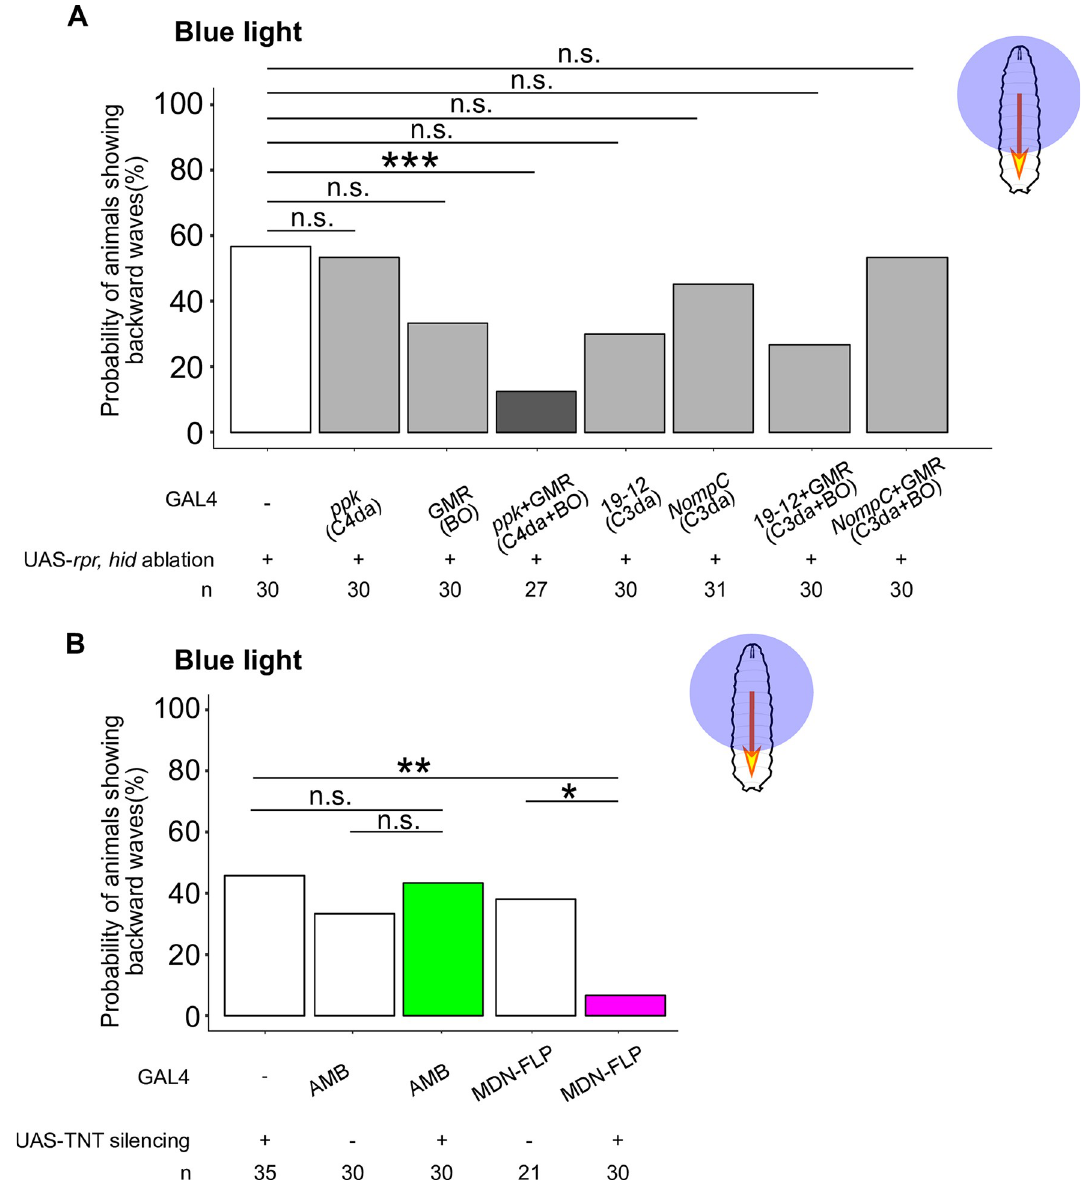
Fig 9. Blue light-induced backward waves are mediated by C4da and BO pathways and require MDN activity. The probability of animals exhibiting backward waves upon blue light application with ablation of sensory neurons (A), or silencing AMBs or MDNs (B). Blue light was applied for 5 seconds. Genotypes are shown in S1 Table. We assessed the statistical significance by Fisher’s exact test with the Holm method. � p < 0.05, �� p <